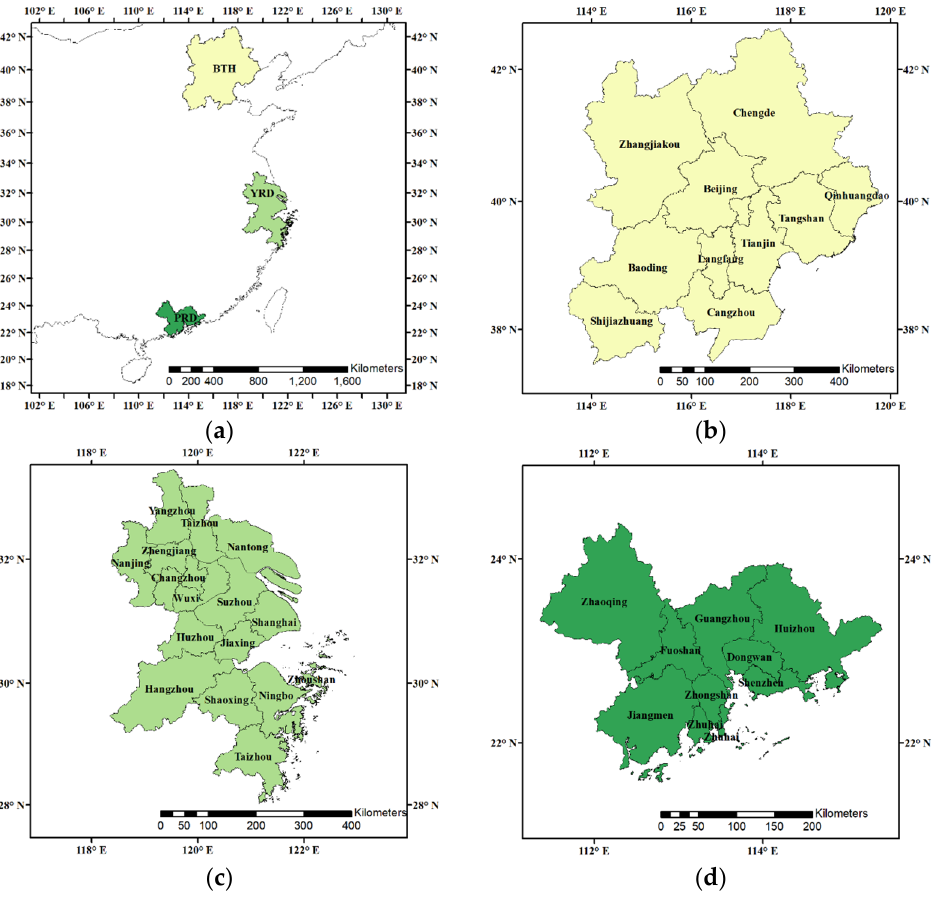
Figure 1. The distribution and composition of China’s three major urban agglomerations ( a ), the 10 cities in BTH ( b ), the 16 cities in YRD ( c ), and the 9 cities in PRD ( d ).